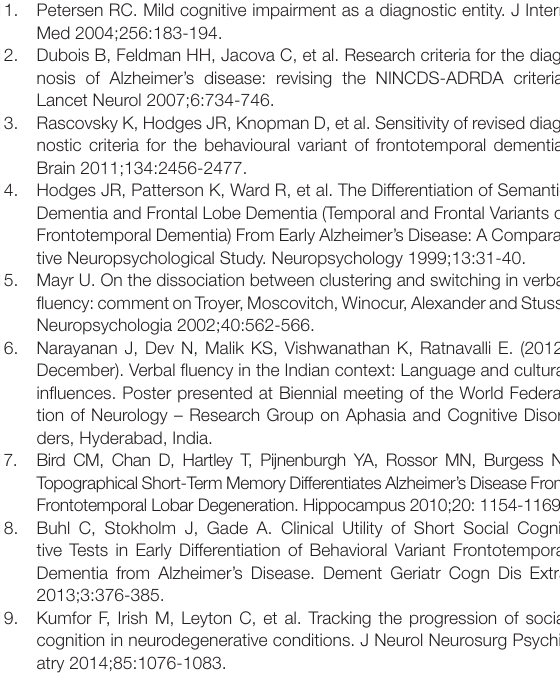
256 Verbal fluency: discrimination between AD, MCI and FTD Ramanan S, et